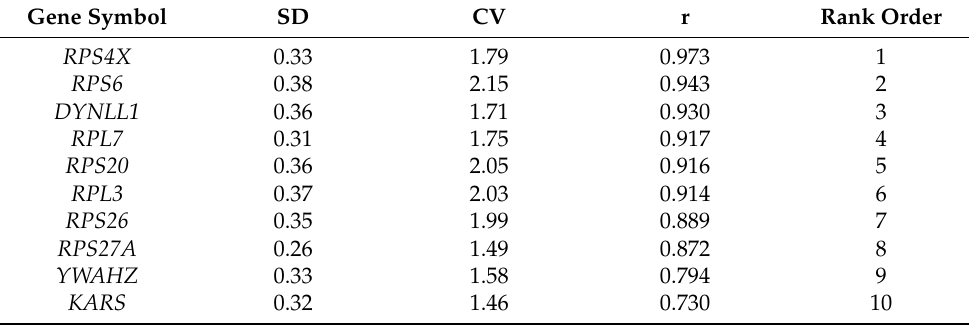
Table 2. Expression stability of RGs according to Bestkeeper analysis.